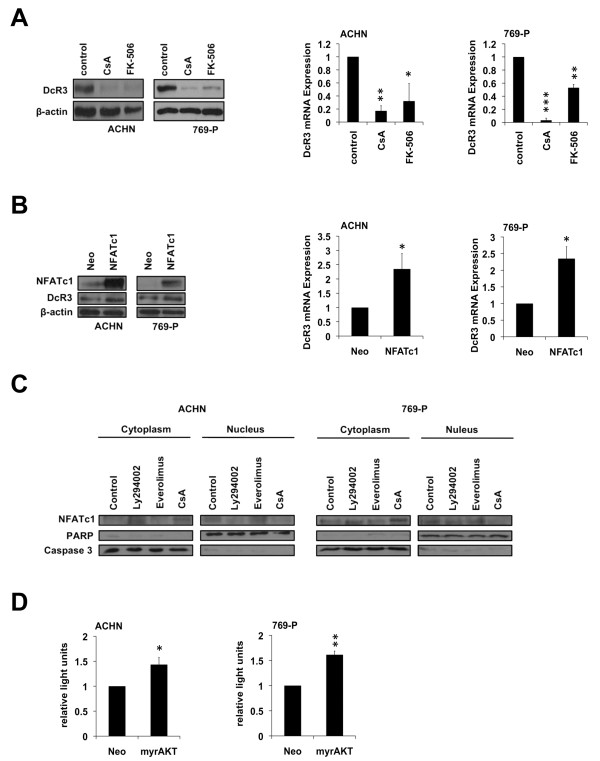
NFATc1 regulates DcR3 expression at a transcriptional level. (A,B) Immunoblot analysis of whole-cell lysates and quantitative real-time-PCR assaying relative DcR3 mRNA expression of ACHN and 769-P cells 24 h after treatment with cyclosporin A (CsA, 25 μM) or Tacrolimus (FK-506, 50 μM) (A); 48 h post transfection with NFATc1 or an empty vector control (neo) (B). Expression data were normalized to internal 18S rRNA expression (mean ± SEM; n=3; *p<0.05, **p<0.01, ***p<0.001; T-test). (C) Immunoblot analysis of cytoplasmic and nuclear fractions of ACHN and 769-P cells after treatment with LY294002 (50 μM), Everolimus (1 μM), or Cyclosporine A (25 μM). (D) Relative NFATc1–luciferase reporter activity of ACHN and 769-P cells 24 h post transfection with myrAkt or an empty vector control (neo) (mean ± SEM; n=3; *p<0.05, **p<0.01; T-test).